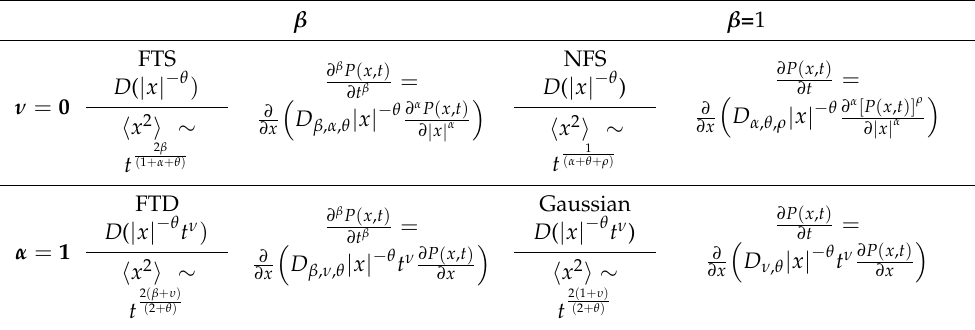
Table 2. Anomalous diffusion with power law diffusion coefficient, D β , α , ν , θ , ρ ( | x | − θ t ν ) . β β = 1